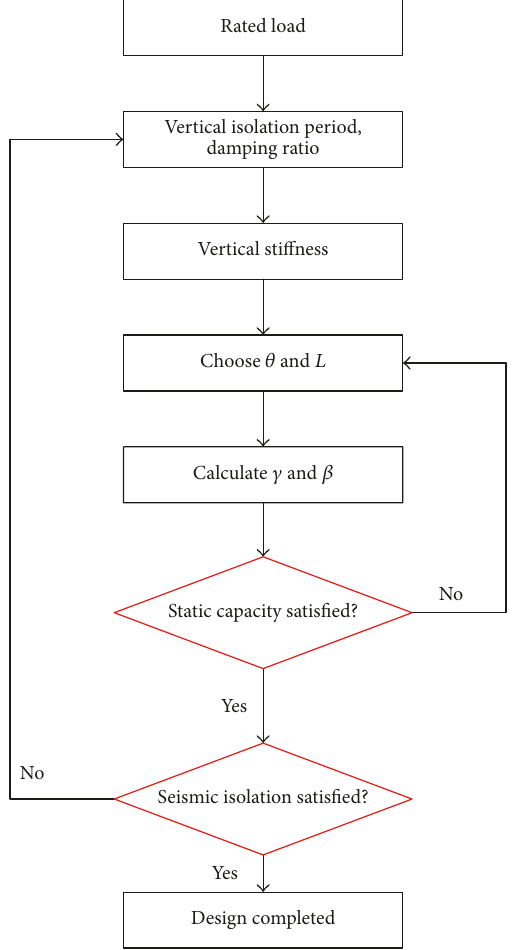
Figure 11: The design